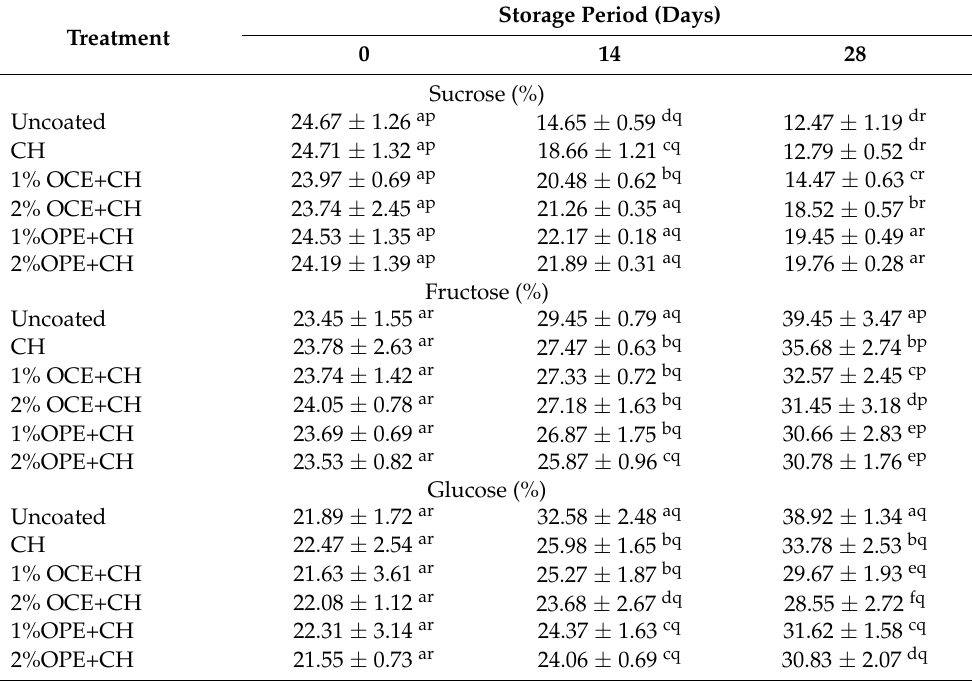
Table 3. Changes in sucrose, fructose and glucose in fresh Barhi dates coated with chitosan (CH) and/or olive-cake (OCE) or orange-peel extracts (OPE) during cold storage at 4 ◦ C for four weeks.